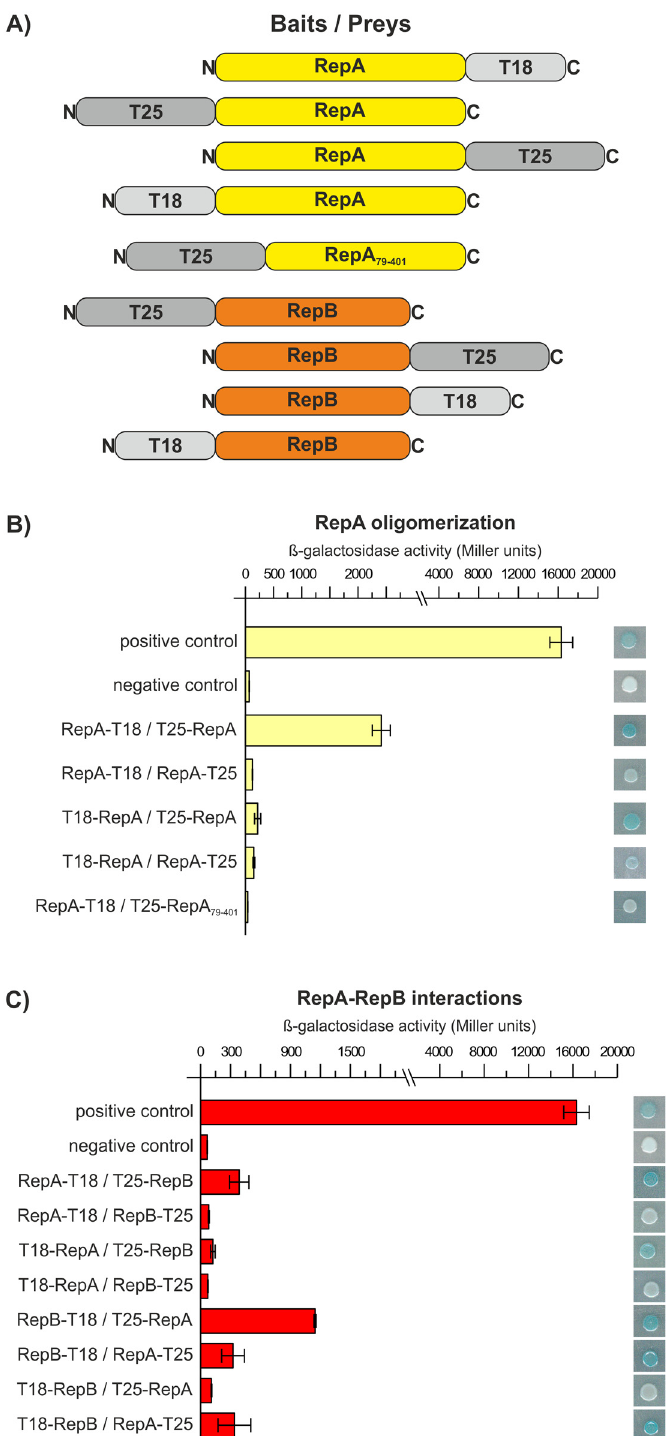
Fig 9. BACTH analysis of interactions of RepA and RepB proteins. (A) The schematic representation of full length RepA and RepB, which were translationally fused to N- and C-terminus of T18 and T25 functional domains of CyaA protein, as well as constructed 'prey' hybrid plasmid which comprised N-terminally truncated RepA fused to T25 domain. (B) RepA/RepA and (C) RepA/RepB interactions in BACTH analysis which were quantified by measuring of β -galactosidase activity (Miller units) in hybrid